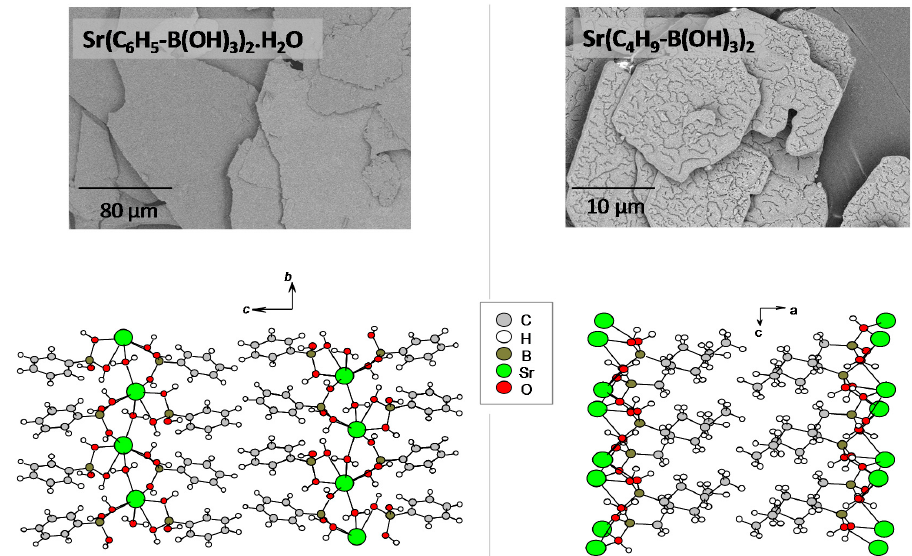
Figure 4. SEM images and crystal structures of Sr(C 6 H 5 -B(OH) 3 ) 2 .H 2 O ( left ) and Sr(C 4 H 9 -B(OH) 3 ) 2